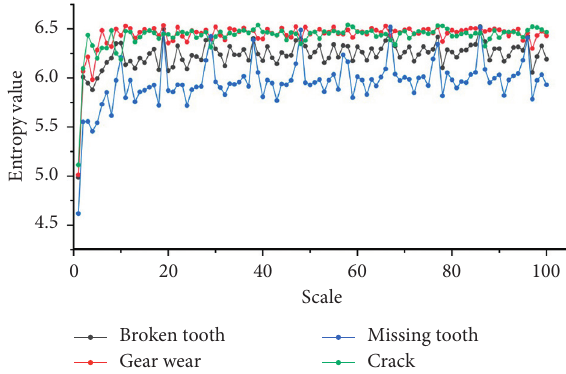
Figure 10: The MMSDE value calculated by the compressed sensing signal changes with the scale.